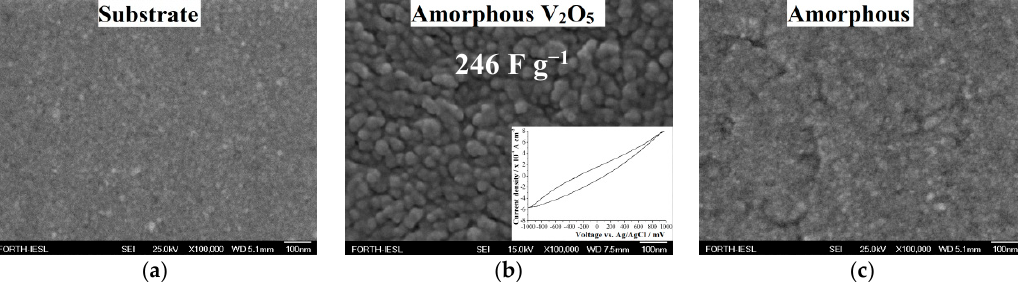
Figure 1. FE-SEM images of vanadium oxides grown by Atmospheric Pressure Chemical Vapour Deposition at 300 ◦ C on ( a ) a SiO 2 -precoated glass substrate for ( b ) 0.8 L min − 1 and ( c ) 1.4 L min − 1 N 2 flow rates through the vanadium precursor bubbler. Inset ( b ) The cyclic voltammetry curve of the as-grown APCVD vanadium oxide for the 0.8 L min − 1 N 2 flow rate for a potential ranging of − 1.000 V to + 1.000 V and a scan rate of 20 mV s − 1 in 1 M LiClO 4 / polypropylene carbonate.